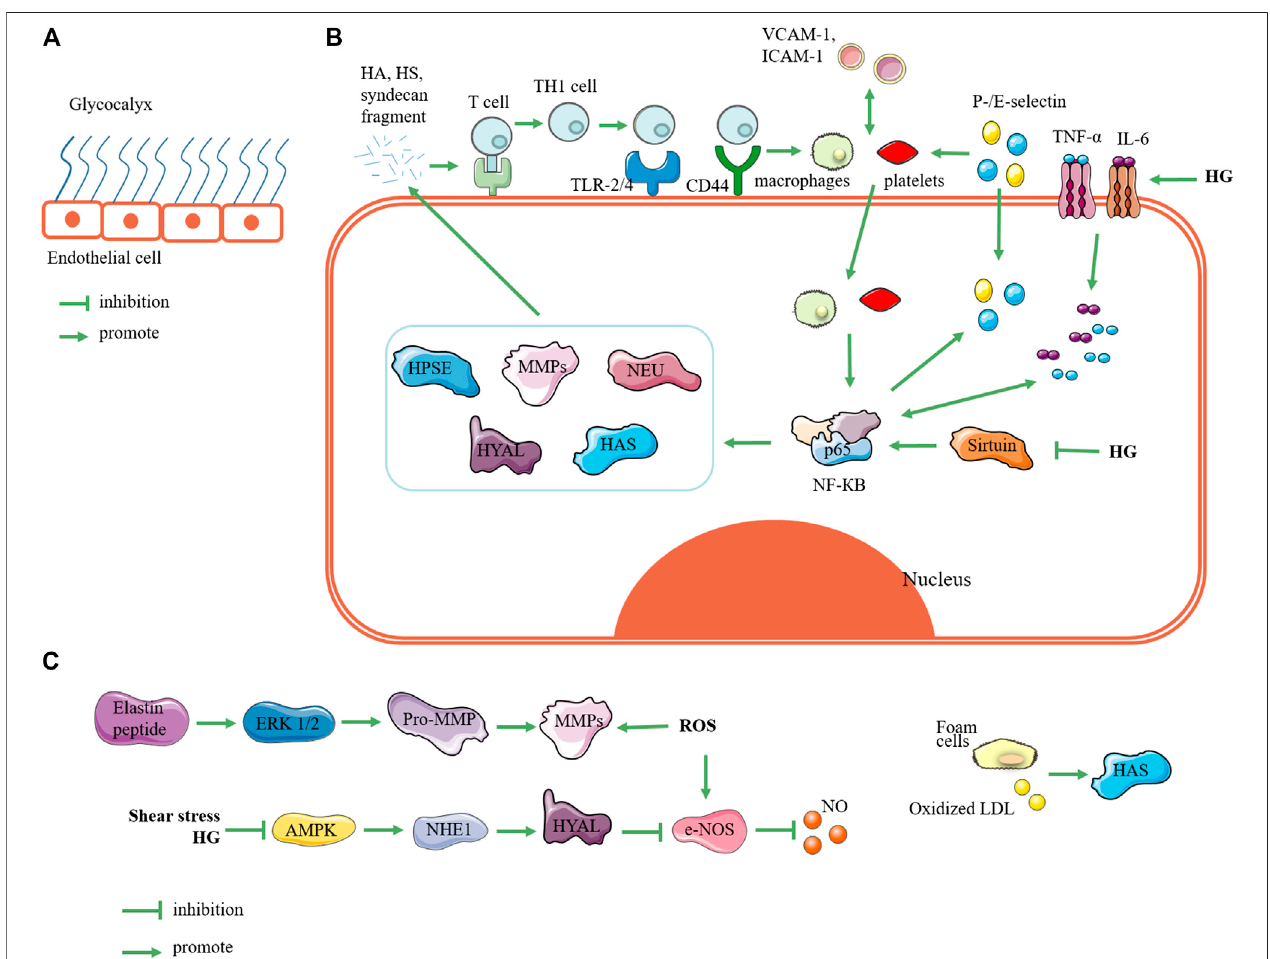
FIGURE 1 | Related mechanisms of enzymes regulating glycocalyx. (A) State of glycocalyx under normal conditions. (B) Glycocalyxglycocalyx state under hyperglycemia.Elevated bloodsugartriggersexpression ofin fl ammatoryfactorssuchasTNFand IL-6,whichcantriggerupregulationofNF- L Bexpression;inturn,this triggers upregulation of HPSE, MMPs, NEU, HYAL, and HAS. These enzymes degrade glycocalyx to produce fragments of hyaluronic acid, heparan sulfate, and syndecan. These fragments activate receptors such as toll-like receptors and CD44, so that T cells are presented and activated into T helper 1 cells. Furthermore, they induces monocyte adhesion such as macrophages and platelets. On the one hand, monocyte adhesion promotes expression of vascular cell adhesion molecule 1 and intercellular adhesion molecule 1, and it triggers the upregulation of P-/E-selectin expression; on the other hand, it can trigger the phosphorylation of NF- L B at position65and activateNF- L B.Thisformsaviciouscircleofglycocalyxdegradation.Inaddition, high glucosecaninhibittheexpression ofsirtuin, whichcanupregulate the expression of NF- L B. (C) Relating other pathways for glycocalyx degradation, reactive oxygen species and elastin peptides can trigger upregulation of MMP expression; shear stress and hyperglycemia can upregulate Na + -H + exchanger 1 through AMP-activated protein kinase (AMPK) pathway to upregulate HYAL expression; foam cells and oxidized low-density lipoprotein can promote HAS expression. Note: HPSE, heparanase; MMP, matrix metalloproteinase; NEU, neuraminidase; HYAL, hyaluronidase; HAS, hyaluronicacidsynthase; HG: high glucose; HA:hyaluronicacid; HS: heparan sulfate; Th1 cell, Thelper 1 cell; TLR-2/4, toll- likereceptors2and4;VCAM-1,vascularcelladhesionmolecule-1;ICAM-1,intercellularadhesionmolecule-1;ROS,reactiveoxygenspecies;NHE1,Na + -H + exchanger 1; LDL, low-density